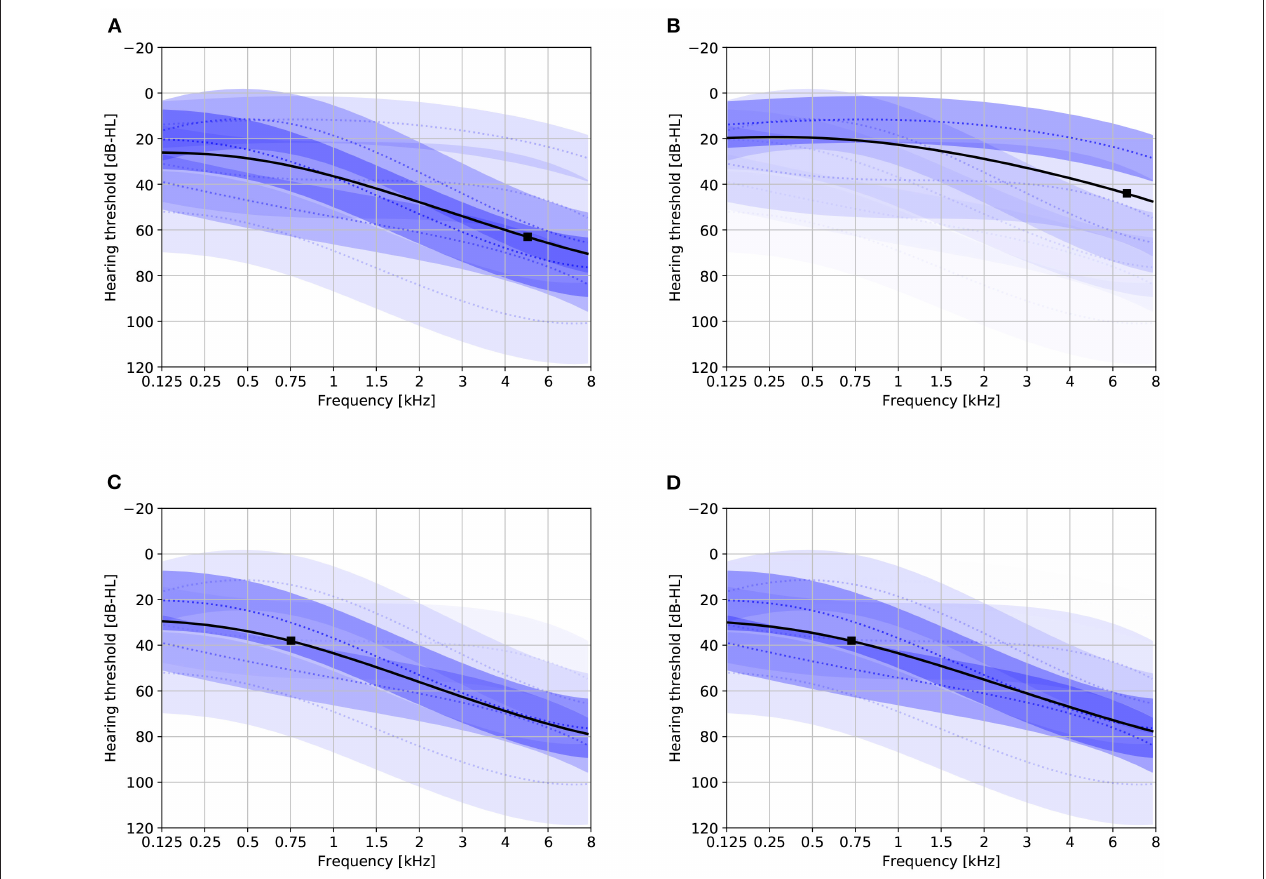
FIGURE 2 | Audiogram plots visualizing the learned model containing six mixture components with various conditionings. Solid black lines denote the initial HT estimate. Dotted blue lines and shaded areas depict the individual GP mixture components ± 1 standard deviation (the transparency is proportional to the mixing weight). Solid black boxes indicate the optimal first stimulus. (A) Not conditioned on age or gender. (B) Age 40, gender unspecified. (C) Age 80, gender unspecified. (D) Age 80, female.